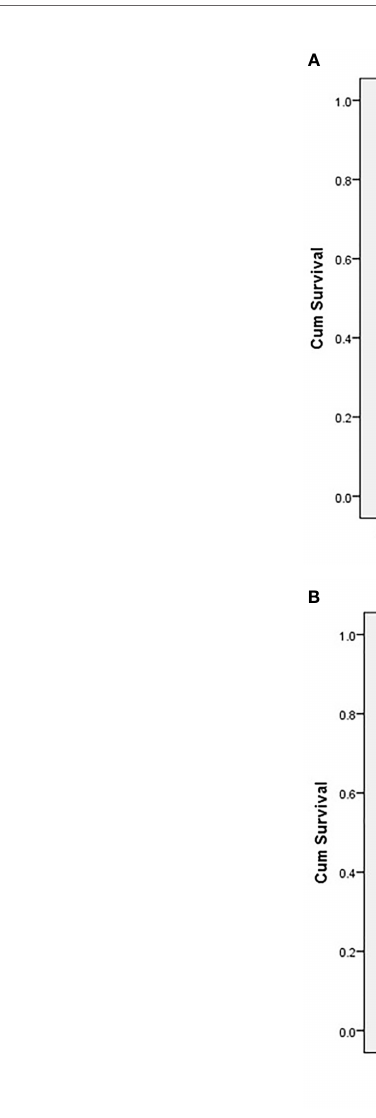
FIGURE 6 | Kaplan-Meier Curve of OS according to ADC response (A) and RECIST classi fi cation (B) . For (A) ;1/green=responder, 3/blue=non-responder. For (B) 1/blue=PD,2/green:SD, 3/beige: PR.